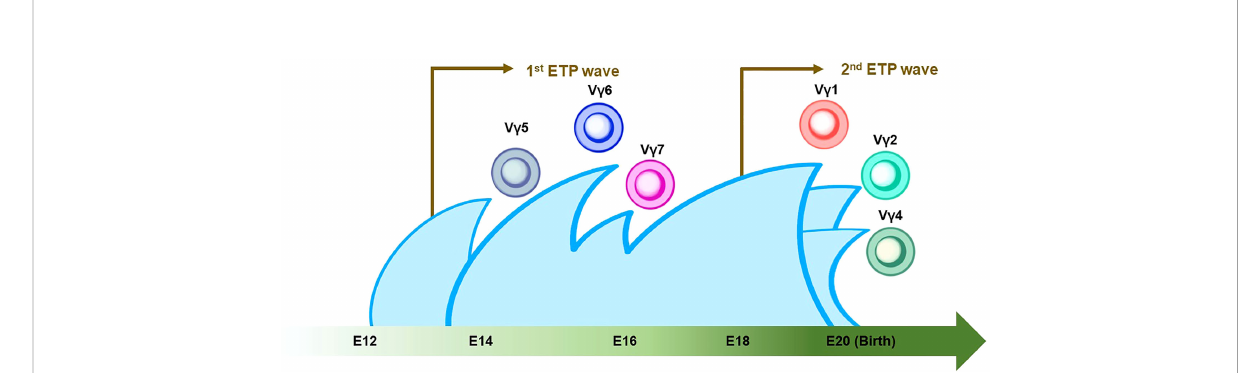
FIGURE 3 Thymic developmental waves of gd T-cell subsets. The green arrow at the bottom indicates the developmental chronology of gd T cells in the de fi nitive wave. V g 5 + /V g 6 + /V g 7 + gd T cells emerge between E14 and E16, followed by the V g 1 + /V g 2 + /V g 4 + gd T cell around birth. Note that the fi rst and second waves of early thymic progenitors (ETPs) come at E13 and E18 (indicated by brown arrows). The V g 2 + gd T cell shares a similar genomic signature with